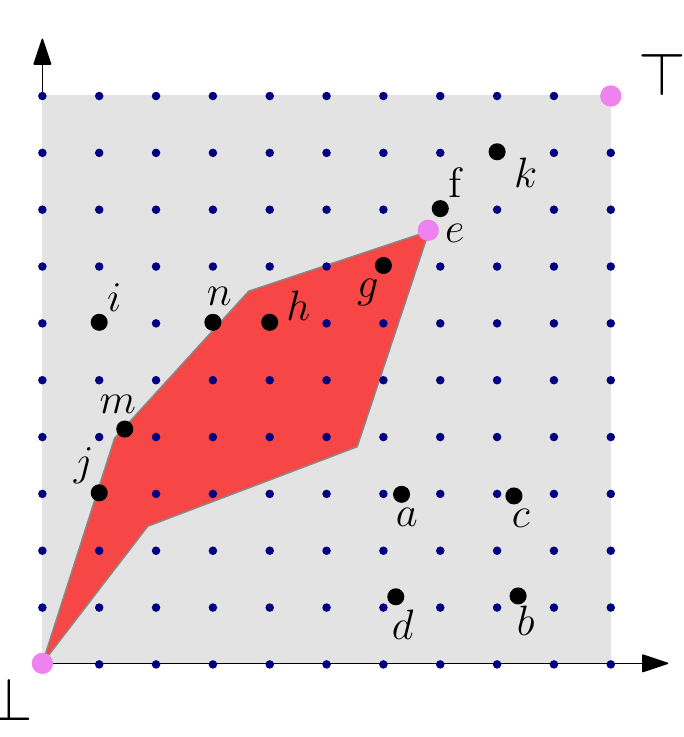
Figure 1. The grid corresponds to the machine lattice L M associated to the lattice L